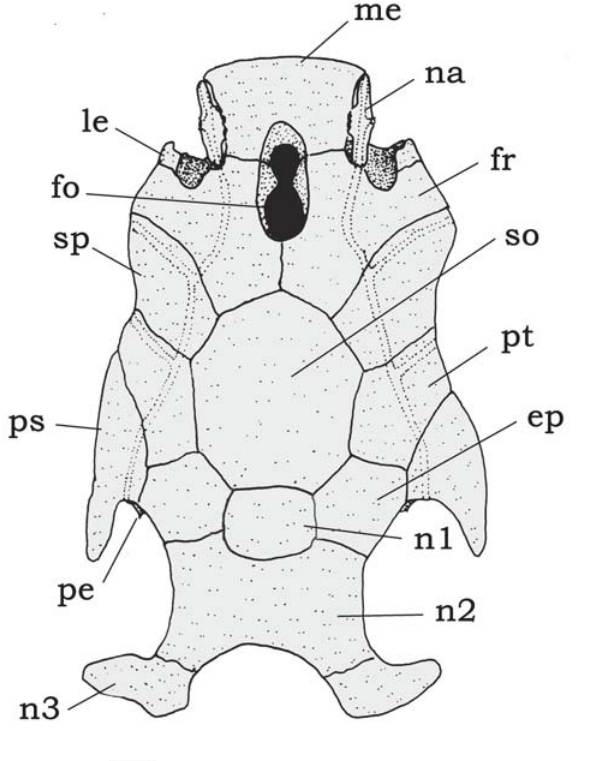
Fig. 34. Neurocranium of Tatia neivai , MZUSP 42570, 60.5 mm SL. Dorsal view. Abbreviations: ep , epioccipital; fo , single cranial fontanel, fr , frontal; le , lateral ethmoid; me , mesethmoid; na , nasal; n1 , first nuchal plate, n2 ; second nuchal plate; n3 , third nuchal plate; pe , posterior epioccipital process; ps , posttemporal-supracleithrum; pt , pterotic; so , supraoccipital; sp , sphenotic. Scale bar = 1 mm.